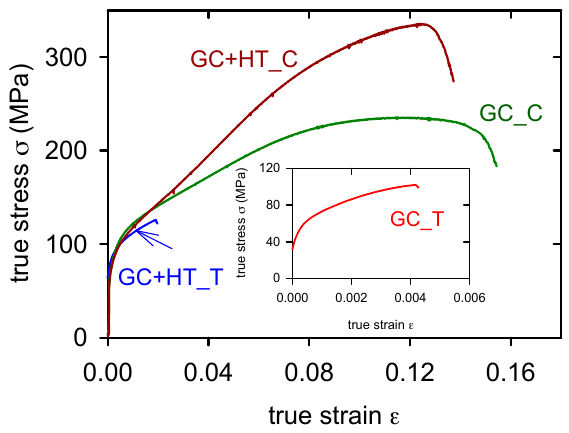
Figure 6. True stress–true strain curves obtained for GC alloy in tension (T) and compression (C). Due to very low ductility of the GC alloy in tension, the curve is introduced in the insert. Table 3. Mechanical characteristics of the Mg-3Zn-2Ca alloy processed by different methods obtained in tension: yield stress, σ 02 , ultimate tensile strength, σ UTS , and strain to fracture, e.